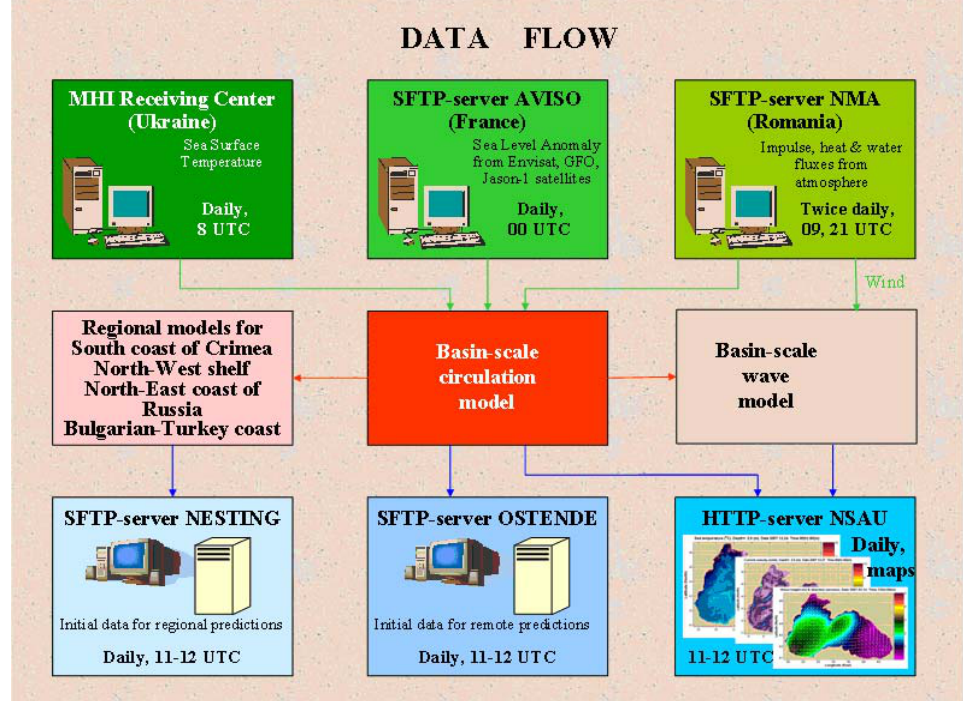
Figure 25 Data flow in the framework of the Black Sea nowcasting/forecasting system. Fig. 25. Data flow in the framework of the Black Sea nowcasting/forecasting Examples of the system products presented on the web are shown on Figure 26.